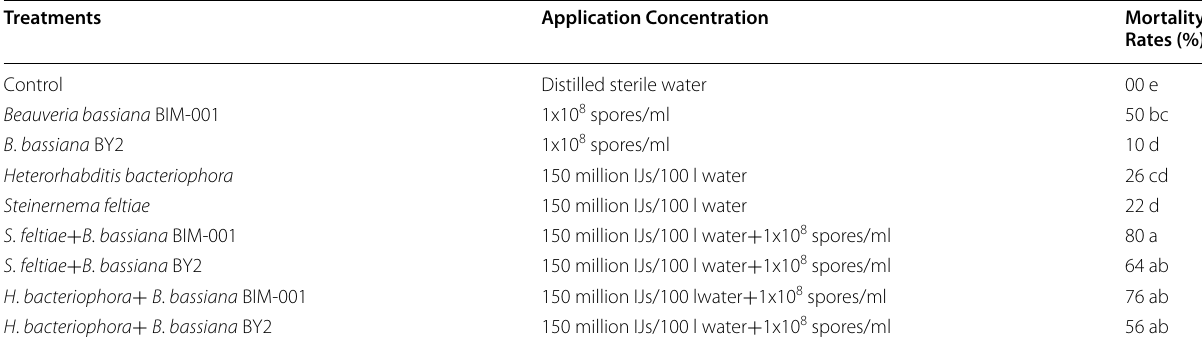
Table 5 Mortality rates (%) after entomopathogenic fungi and nematodes simultaneously applications of pupae of Leptinotarsa